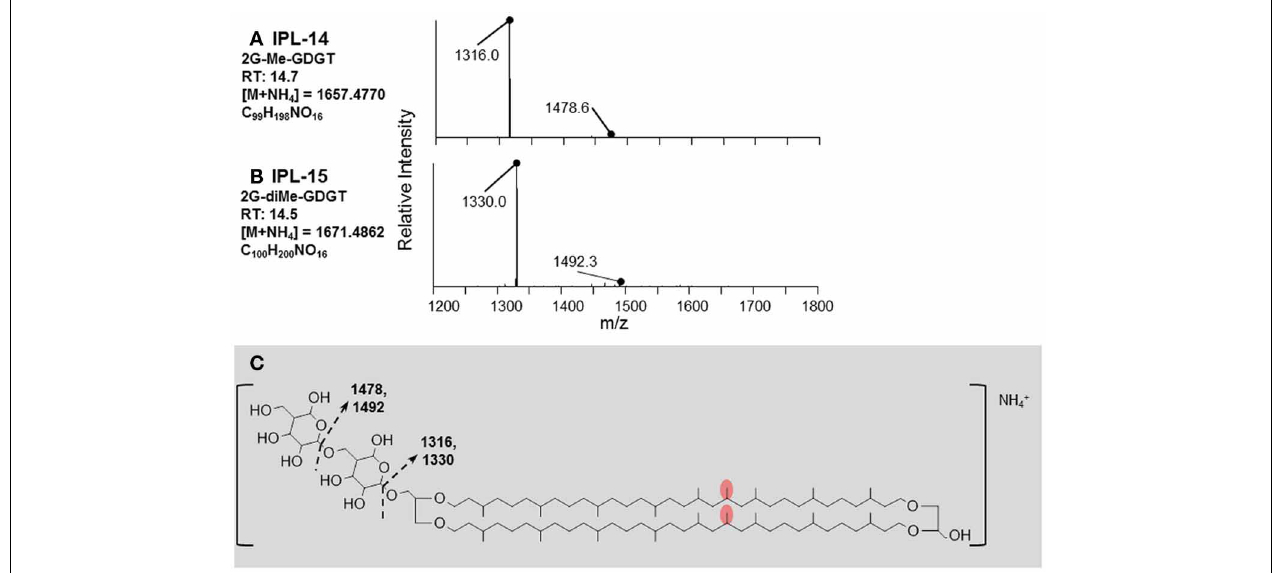
FIGURE 3 | Identification of diglycosidic IPLs containing methylated and dimethylated GDGT core lipids produced by T. kodakarensis . (A) The retention time, exact mass, elemental formula, and MS/MS fragmentation patternof2G-Me-GDGT. (B) Theretentiontime,exactmass,elementalformula,